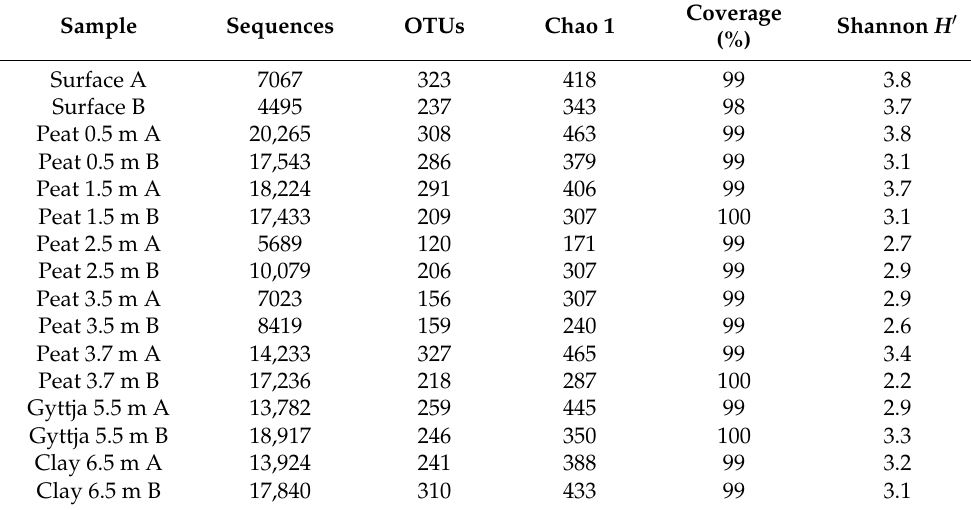
Table 5. Obtained number of fungal ITS1 region sequence reads (Sequences), observed (OTUs) and estimated (Chao1) number of fungal OTUs, Good’s OTU coverage (%) estimated from the Chao1 (Coverage), and diversity index (Shannon H (cid:48) ) calculated from the sequence data. The data were rarefied to 2000 sequences for calculating the number of OTUs, Shannon index, Chao1 estimate, and Good’s coverage. The coverage describes the percentage of OTUs detected from the rarefied data set compared to the Chao1 estimated number of OTUs determined from the rarefied data. Samples A and B are the duplicate samples from the same layer and the DNA was extracted using Extraction Buffer SL1 and SL2 for sample A and B,